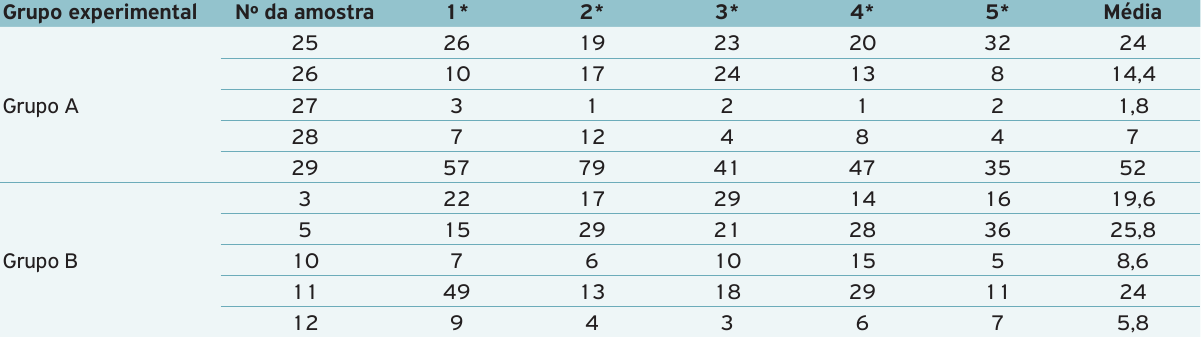
Tabela 1. Valores absolutos do número total de células epiteliais e inflamatórias observadas em cada campo linear avaliado e valor médio de células encontrado em cada amostra de lavado vesical de bovinos positivos para hematúria enzoótica bovina. Grupo experimental Nº da